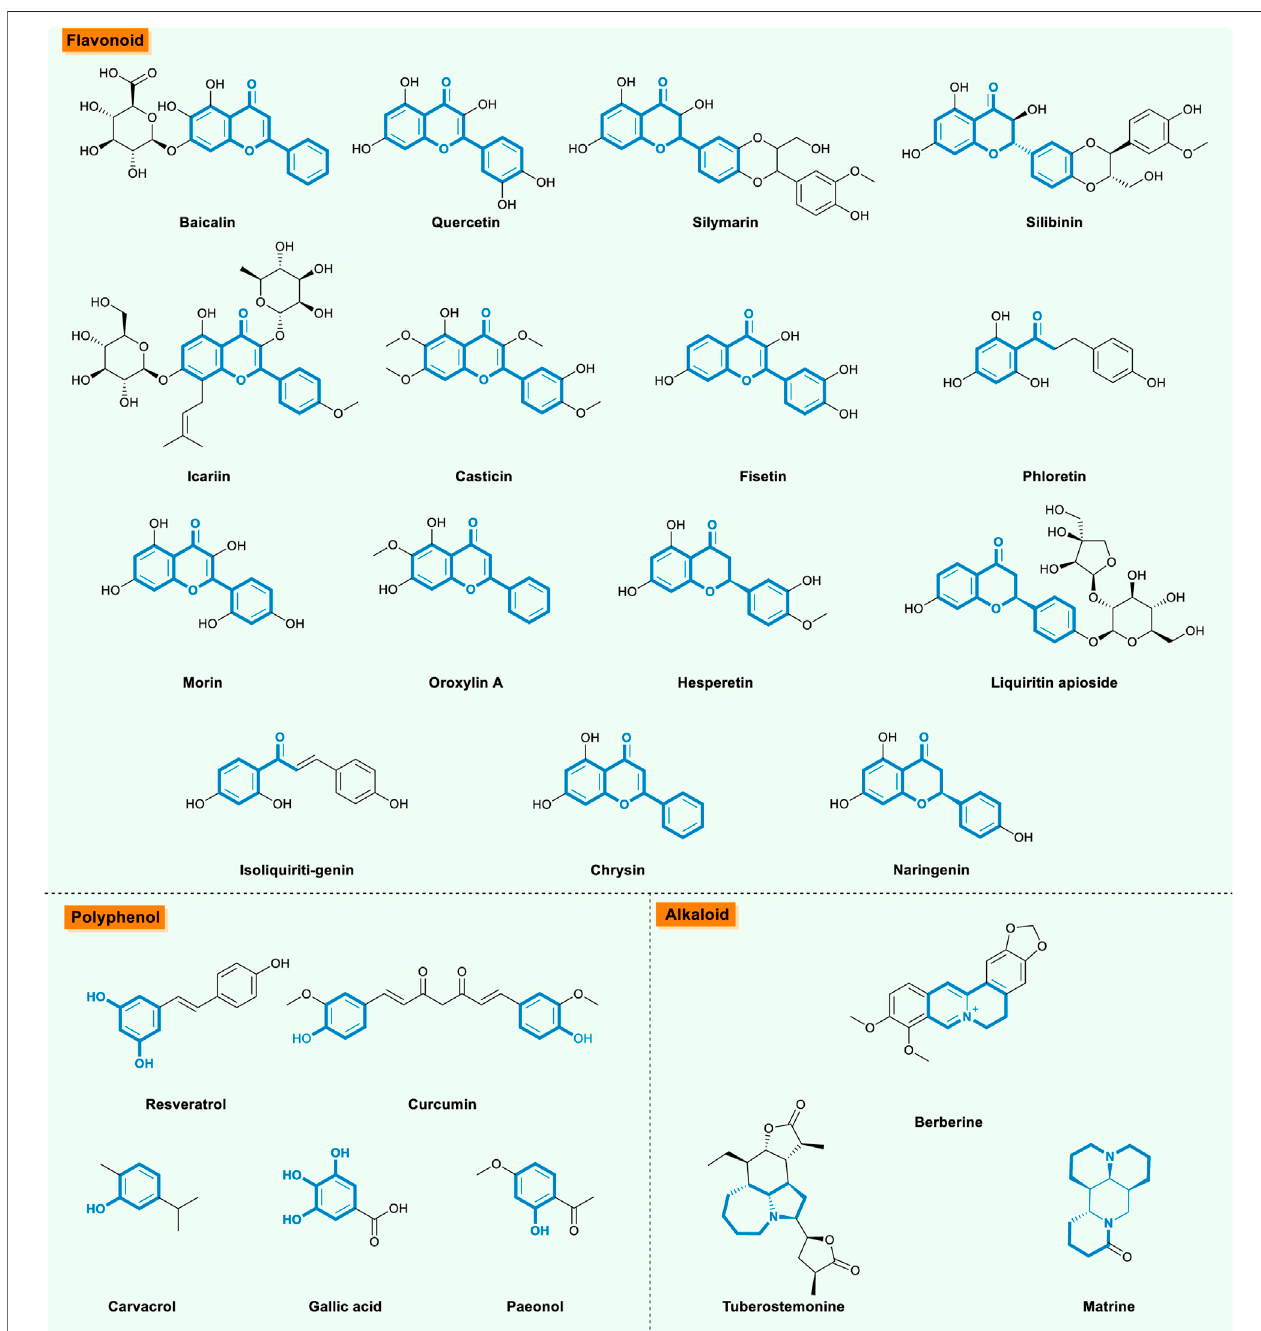
FIGURE 4 | The bioactive natural compounds from fl avonoid, polyphenol, and alkaloid.